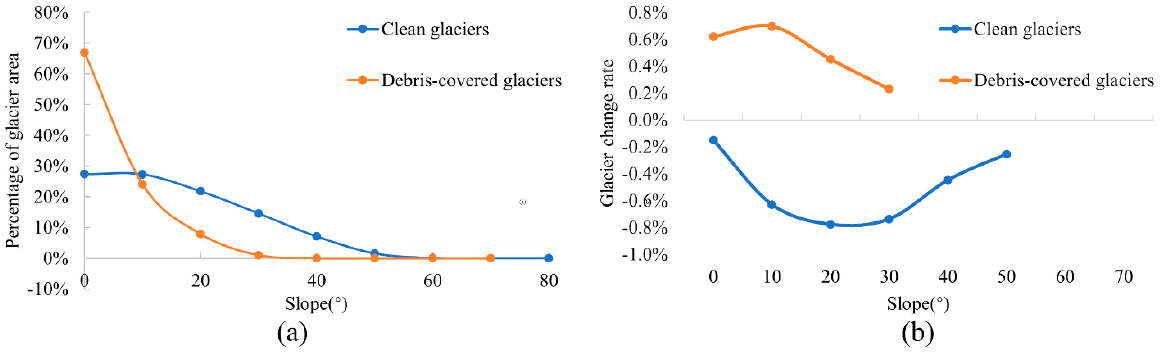
Figure 9. Glacier changes on the Tibetan Plateau at different slopes. ( a ) Percentage of area and ( b ) ( b ) average annual rate of change at different average annual rate of change at different elevations.